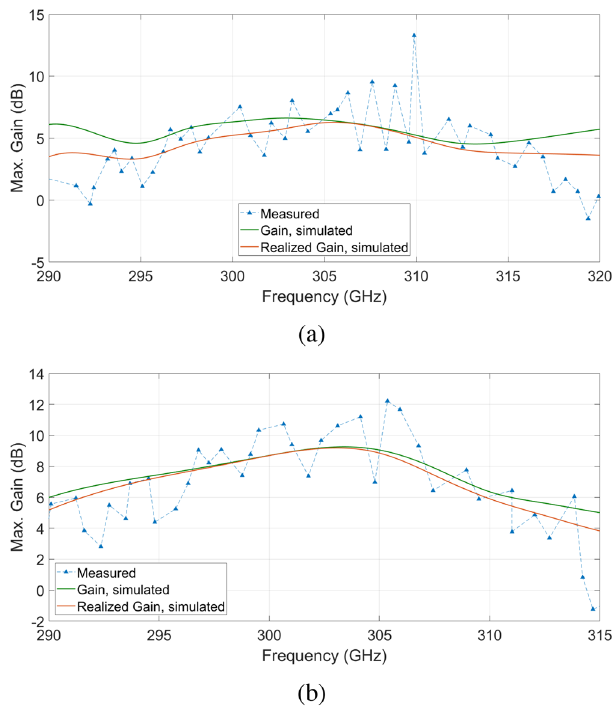
Figure 9. Measured and simulated gain of the non-MM-loaded and MM-loaded antennas over the frequency range of interest.